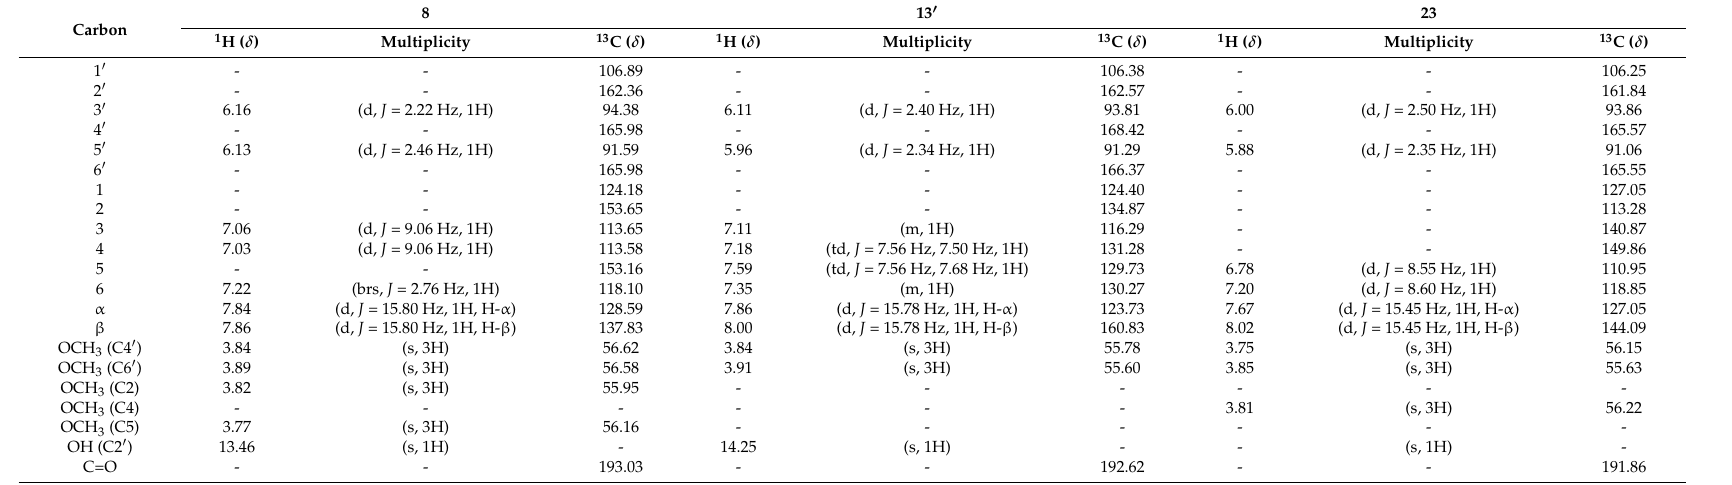
Table 1. 1 H- (600 MHz) and 13 C- (150 MHz) NMR data for compound 8 , 13 and 23